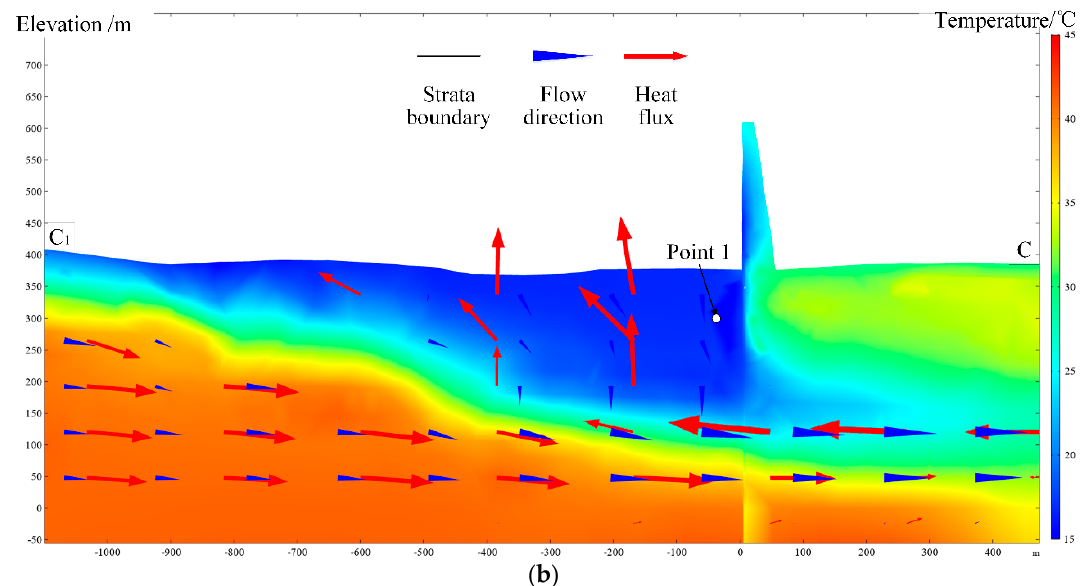
Figure 16. Thermal and seepage distribution after impoundment (27 November 2019): ( a ) B–B1 section in Figure 13; ( b ) C–C1 section in Figure 13.